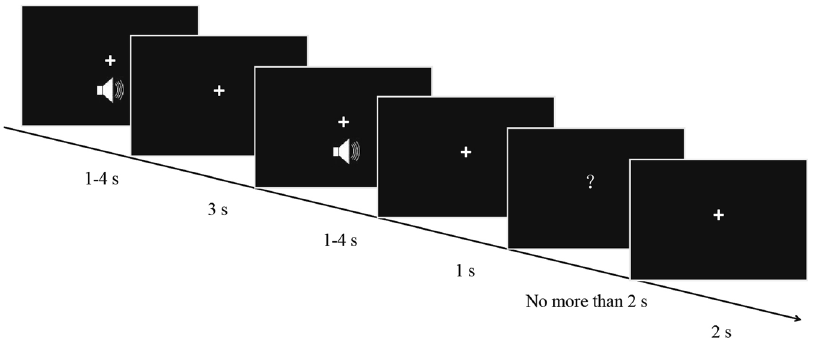
Figure 1. Trial sequences and durations of each screen presentation. Auditory stimuli were randomly presented for 1, 2, 3, or 4 s. Each trial starts with a pure tone (sample), followed by a 3-s interval (the delay/maintenance phase). Next, a second pure tone (probe) is presented. Participants press ‘1’, ‘2’, or ‘3’ correspondingly after estimating the duration of the second pure tone (probe) as shorter, equal to, or longer than the first tone